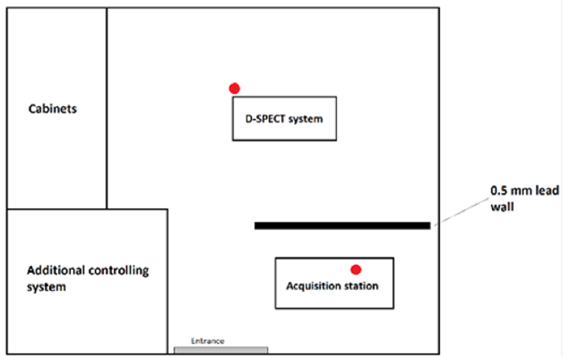
Figure 1. Schematic drawing of D ‐ SPECT acquisition room with detectors’ locations (red circles).